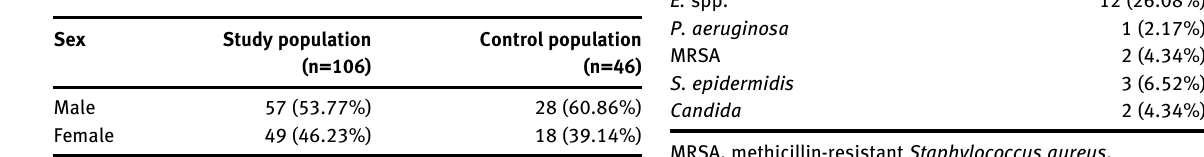
Table  : Sex wise distribution among culture positive in study and control group population.